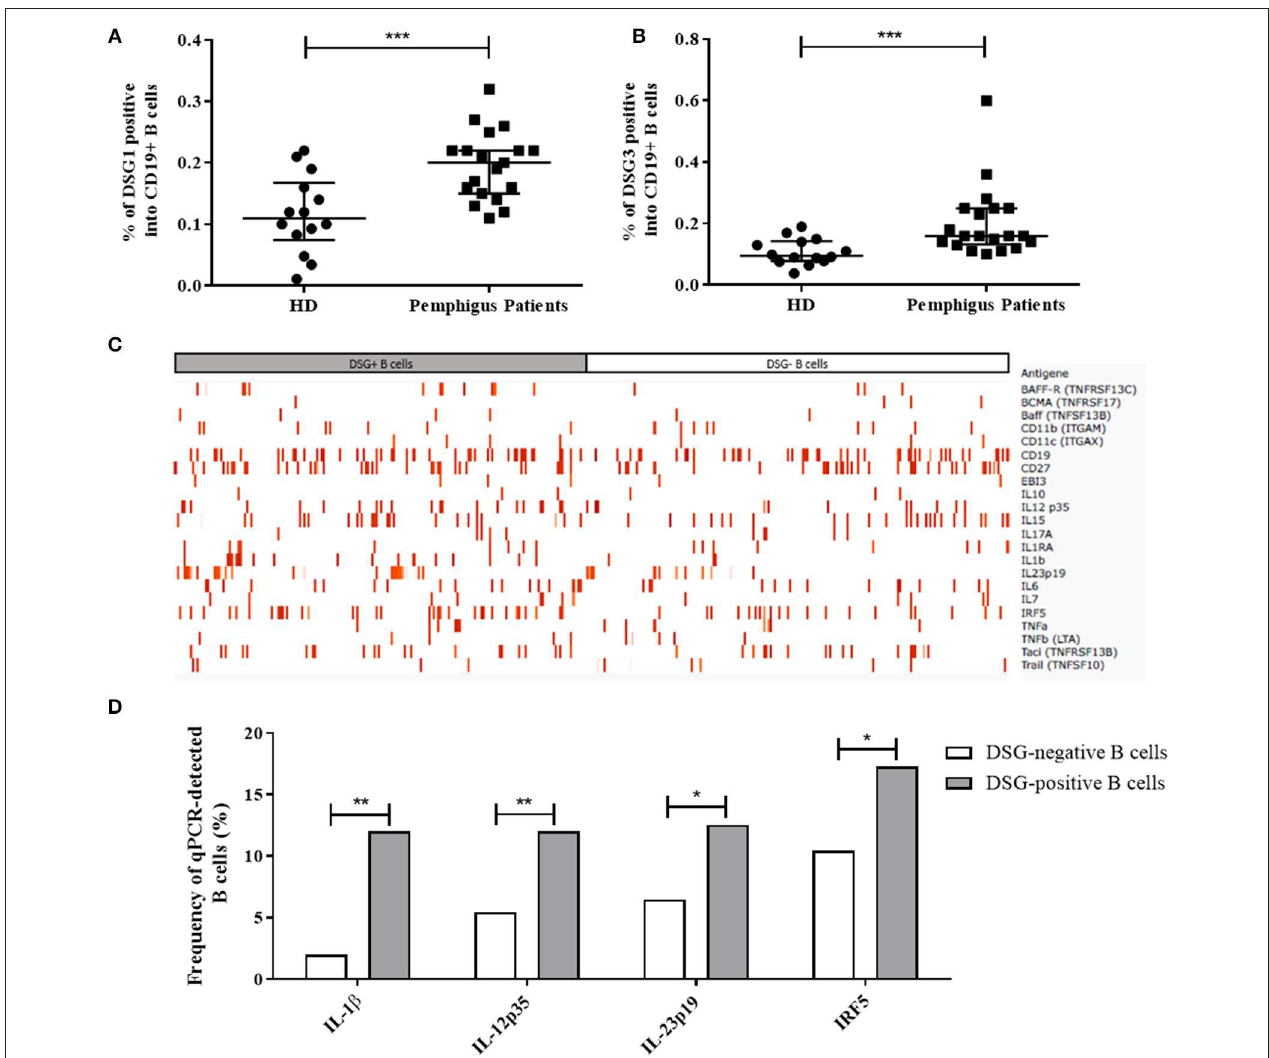
FIGURE 1 | (A,B) Percentage of autoreactive DSG1-positive (CD19 + DSG1 + ) B cells (A) and DSG3-positive B cells (CD19 + DSG3 + ) (B) among total B cells (CD19 + ) collected in 14 healthy donors and 20 pemphigus patients at baseline. Median with interquartile range were compared using the Mann-Whitney t -test. (C) Intensity of gene expression in one-cell sorted DSG-positive B cells (in gray n = 191 cells) and non-autoreactive DSG-negative B cells (in white, n = 201 cells) from pemphigus patients. The color intensity in each sorted cell depended on the 1 CT value relative to GAPDH house-keeping gene expression. Non-detected genes in one-cell qPCR were excluded from the map. (D) Comparison of the baseline frequencies of cells expressing the IL-1 β , IL-12p35, IL-23p19 genes, and the transcription factor IRF5 gene between DSG-positive autoreactive B cells (gray columns, n = 191 cells) and non-autoreactive DSG-negative B cells (white columns, n = 201 cells) from pemphigus patients. Frequencies were compared using the Fisher’s exact